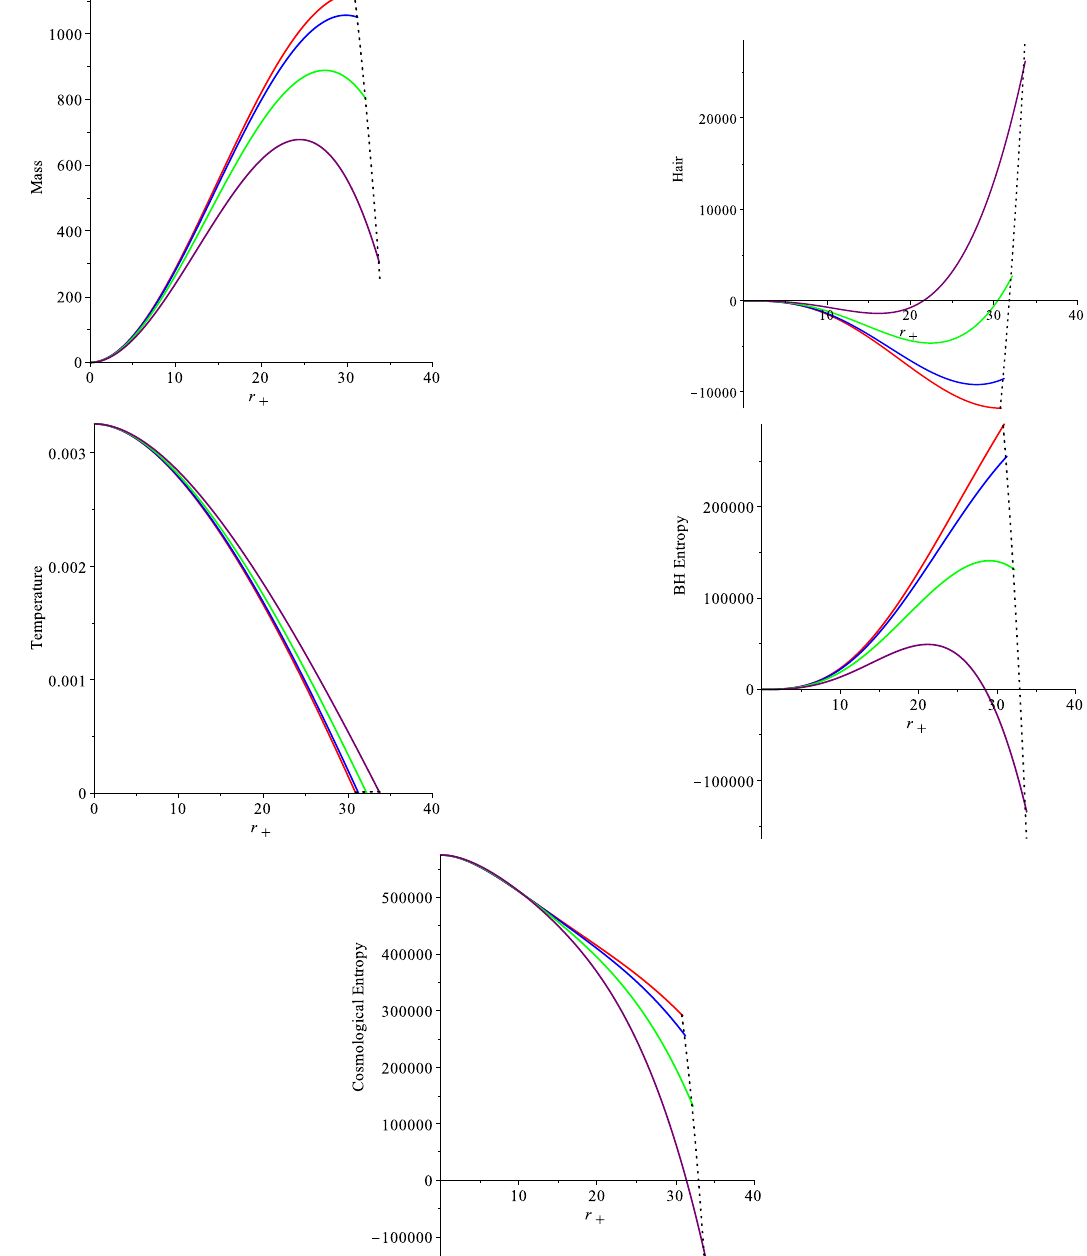
Figure 1 . The thermodynamic parameters of the charged hairy asymptotically de Sitter black holes: the case of P = (cid:0) 0 : 0001. The f red; blue; green; purple g curves correspond to the potential (cid:8) = f 0 : 1 ; 1 ; 2 ; 3 g respectively . The dotted line represents the Nariai limit.